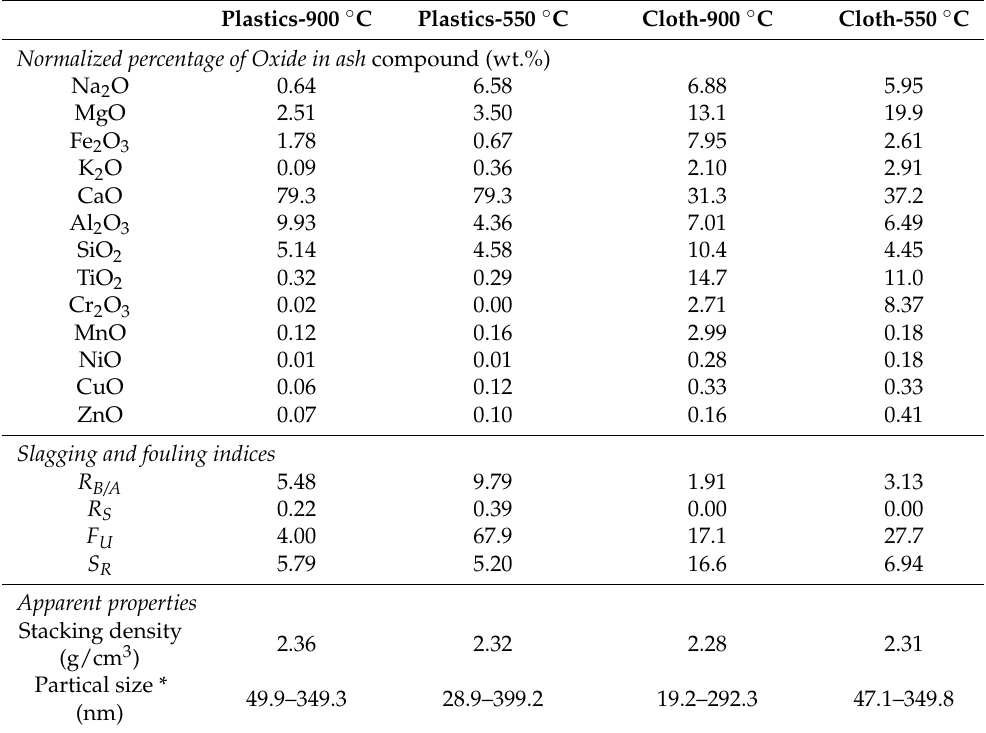
Table 4. Ion content in ash from waste plastics and cloth Metal combustion at different temperatures (wt.%). Plastics-900 ◦ C Normalized percentage of Oxide in ash compound